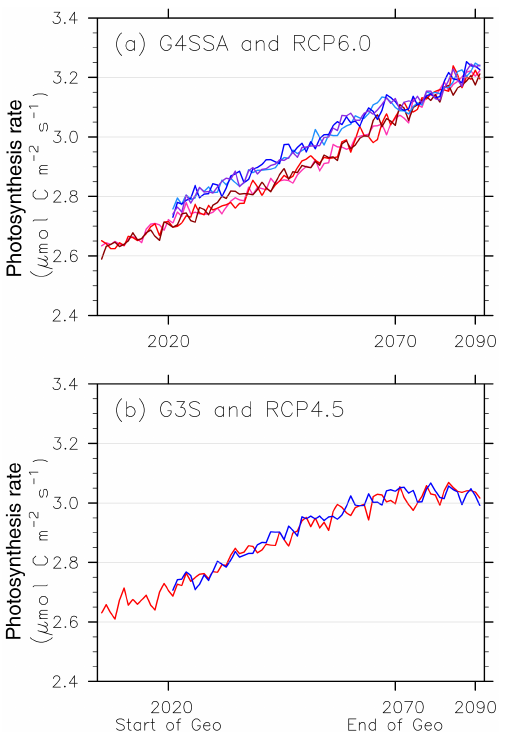
Figure 2. Land average photosynthesis rate without explicit nutrient limitation (a) under sulfate injection geoengineering (G4SSA) (blue lines) and RCP6.0 (red lines) and (b) under solar constant reduction geoengineering (G3S) (blue line) and RCP4.5 (red line).